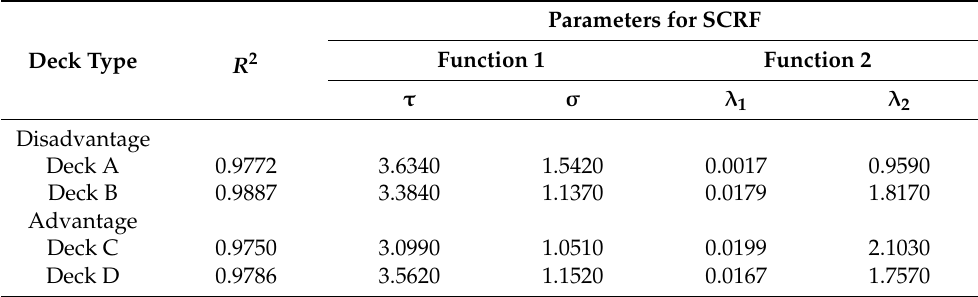
Table 2. Four parameters showing the best SCRFs for the four card